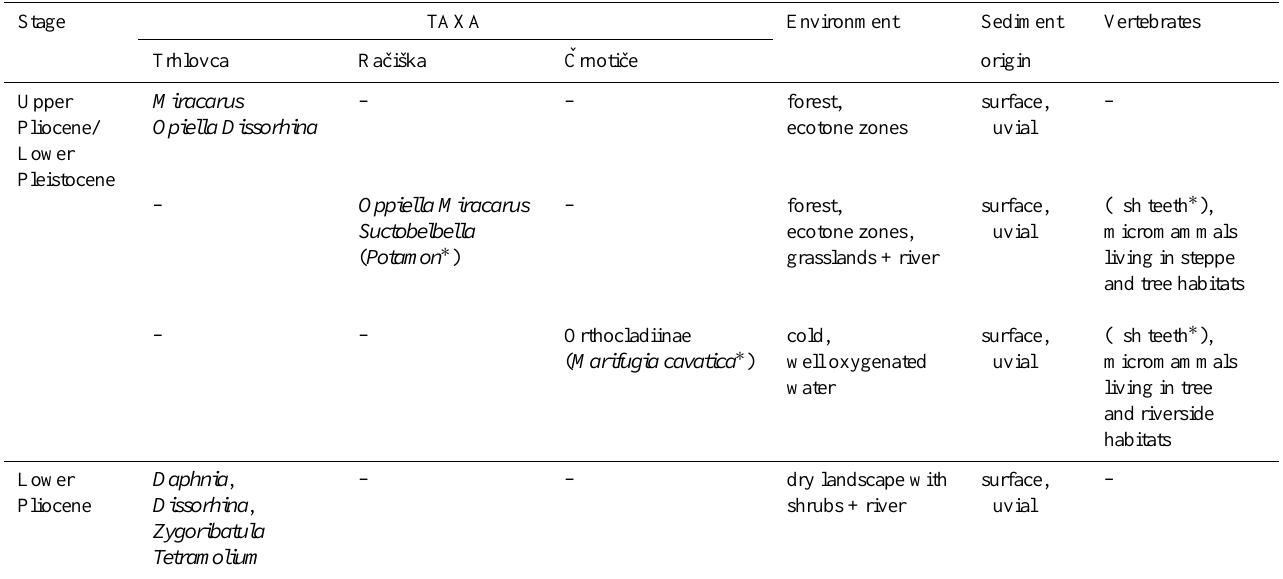
Table 2. Taxa found in cave sediments of Slovenia with the corresponding vegetation, sediment type and origin, and vertebrate